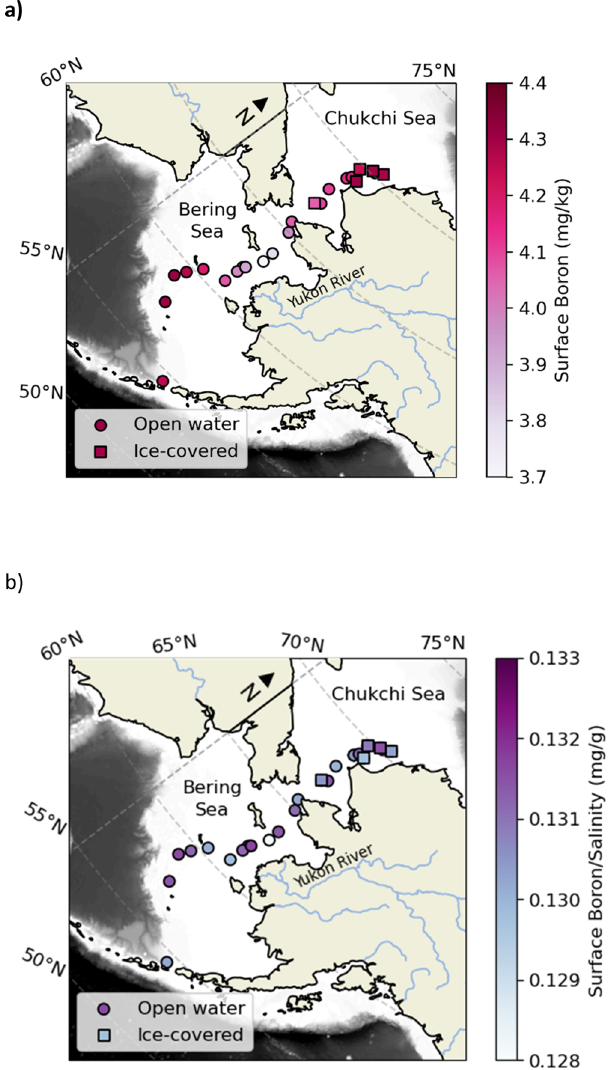
Fig. 1 Station location on the RV Sikuliaq between May 20th to June 14th, 2021. Ice covered stations are depicted with square markers and open water stations are represented in round markers. a Boron concentrations in surface water samples across transect in mg kg − 1 and b boron to salinity ratios for all surface water